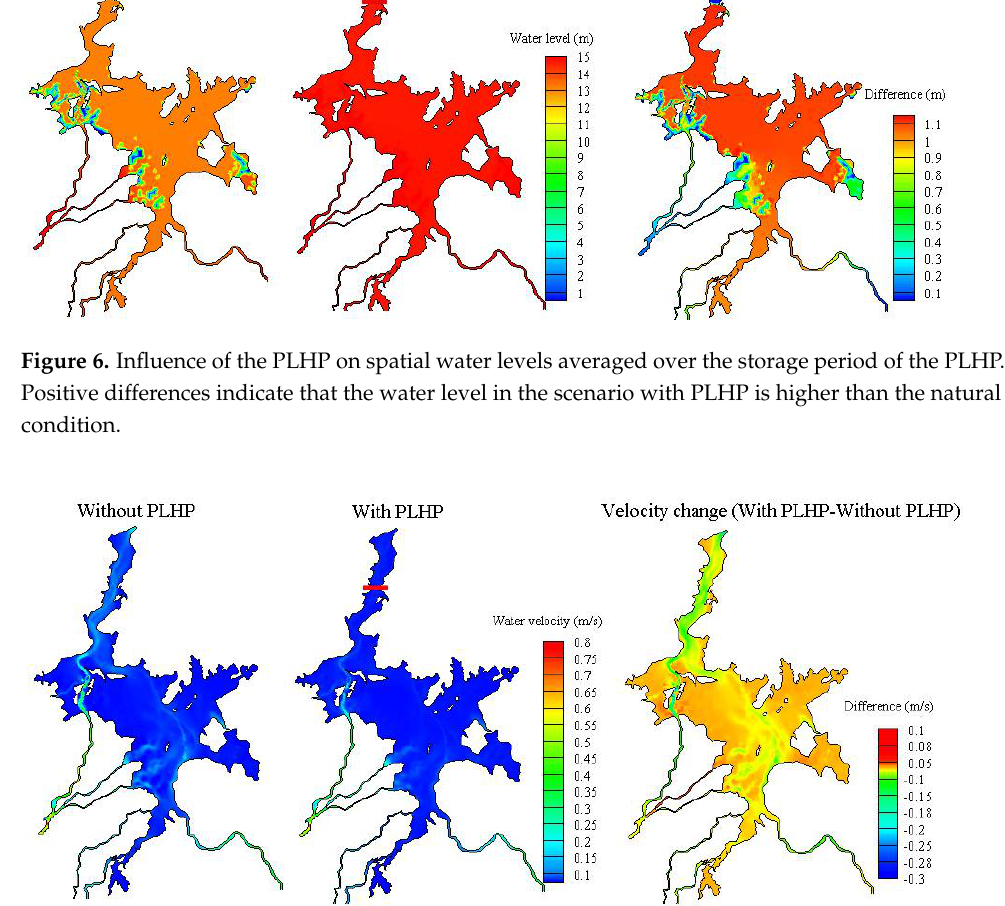
Figure 6. Influence of the PLHP on spatial water levels averaged over the storage period of the PLHP. Positive differences indicate that the water level in the scenario with PLHP is higher than the natural condition.